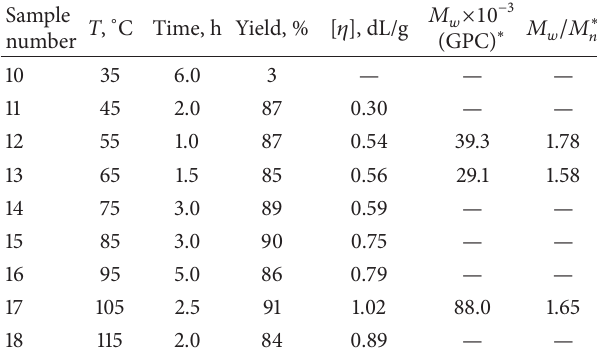
Table 2: EMROP of pentadecalactone. Dependence of reaction yield and polymer intrinsic viscosity on amount of water added to the enzyme before the reaction.